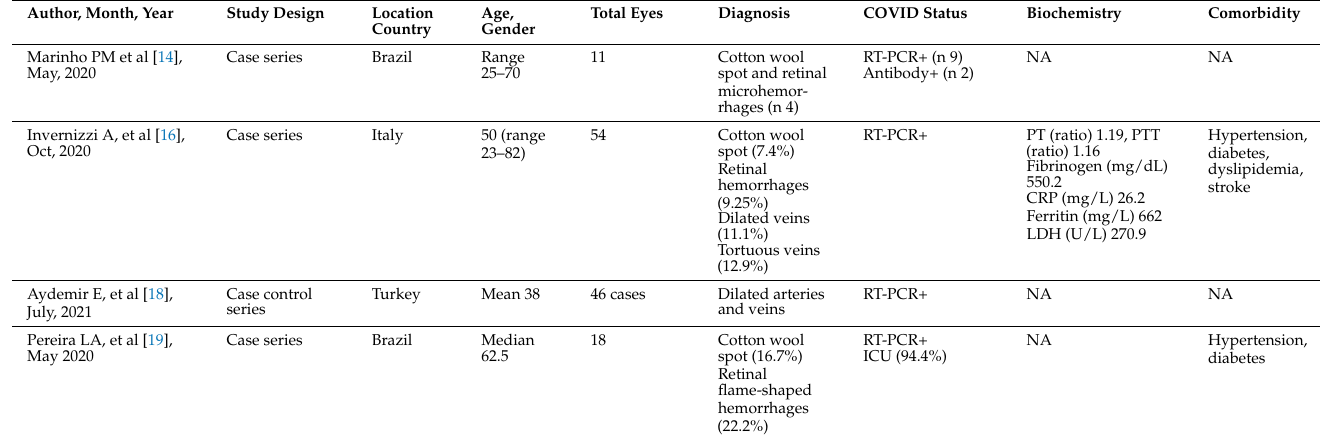
Table 1. Demographic and clinical manifestations of patients with retinal microvasculopathy.